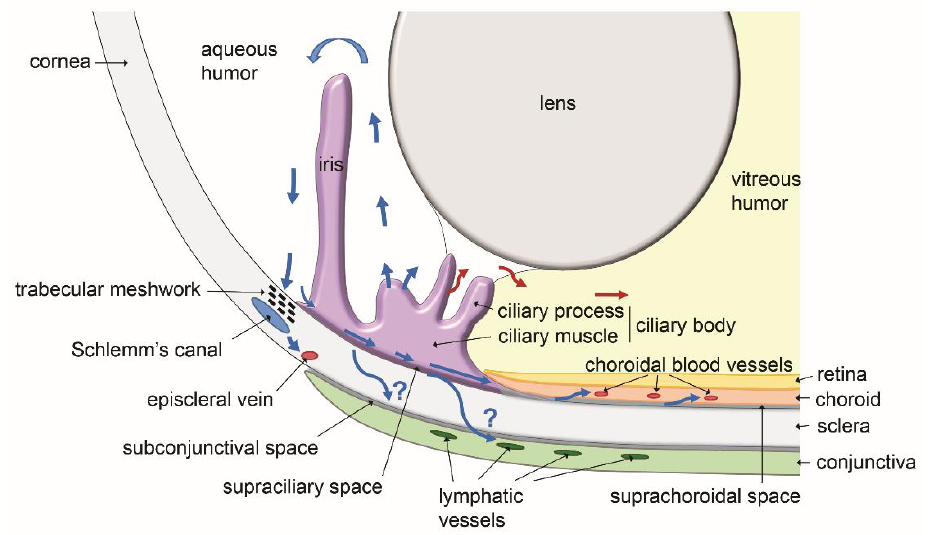
Figure 4. Schematic representation of the routes of aqueous humor transport in the ocular anterior region (blue arrows: outflow; red arrows: inflow). Aqueous humor is produced by the ciliary processes. Although some inflow could occur towards the posterior region of the eye, most of the aqueous humor flows in the anterior chamber and exits through the iridocorneal angle. Two major drainage pathways are well characterized (blue arrows): the conventional trabecular meshwork and Schlemm’s canal pathway, and the uveoscleral non-conventional route through the supraciliary and the suprachoroidal spaces. By both of these pathways, aqueous humor reaches the blood venous circulation in either episcleral veins or choroidal vessels, respectively. A third route using the subconjunctival space and/or the lymphatic vessels of the conjunctiva also appears to exist, draining aqueous humor to the neck lymph nodes. Scheme inspired from [14].